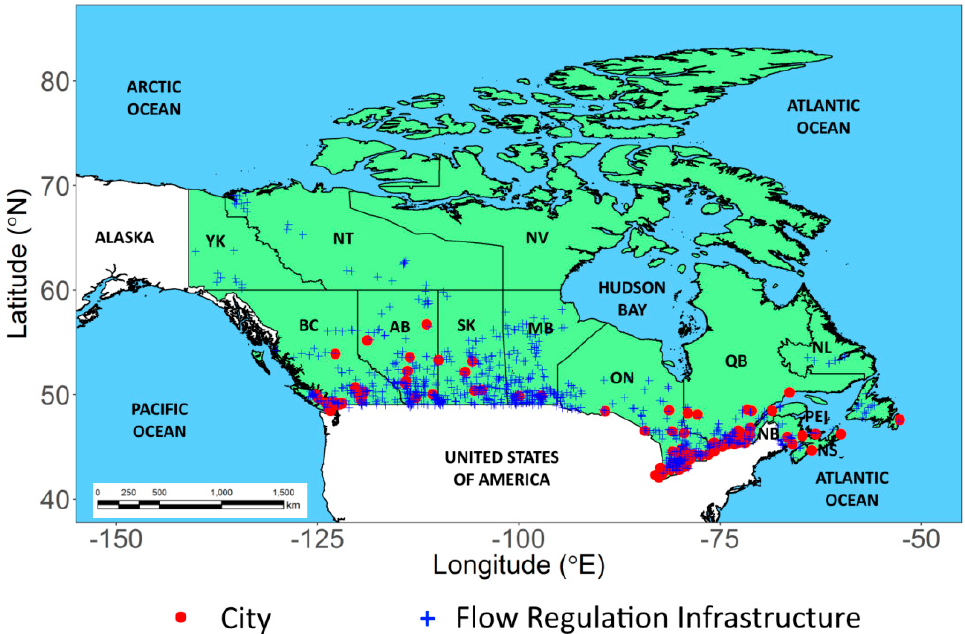
Figure 1. Canada, its administrative boundaries, surrounding countries, and waterbodies. The location of cities and flow regulation locations considered for assessment in this study are shown as red dots and blue crosses respectively.